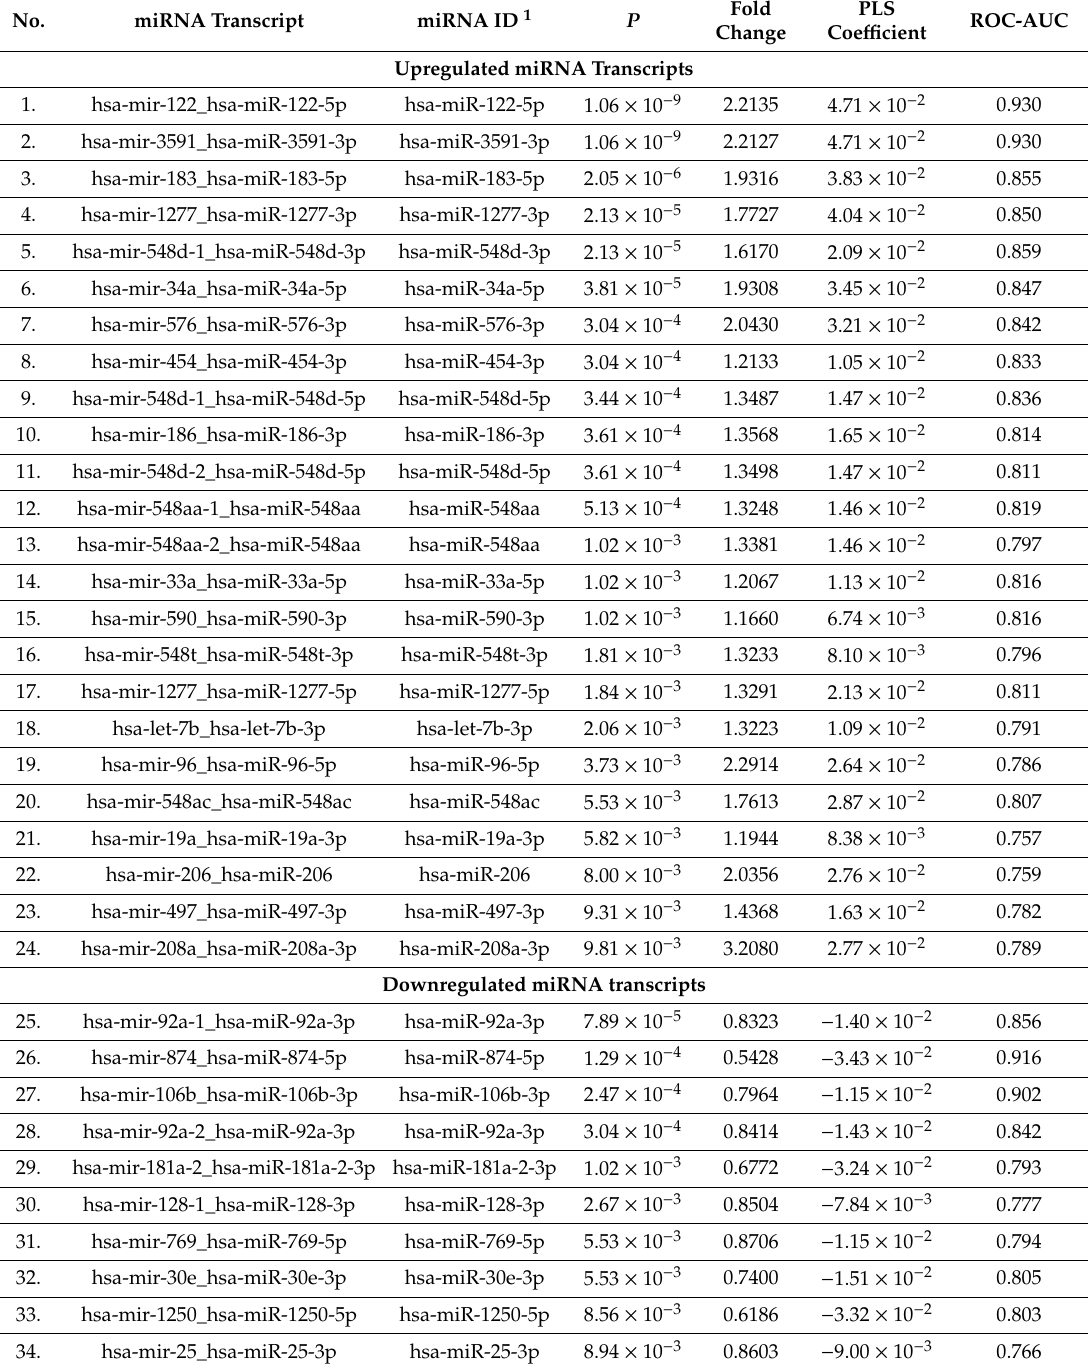
Table 2. Set of 34 di ff erentially expressed miRNA transcripts resulted from DESeq2 analysis with p < 0.01 with statistical significance confirmed by UVE-PLS analysis in 34 patients with chronic venous disease compared to 19